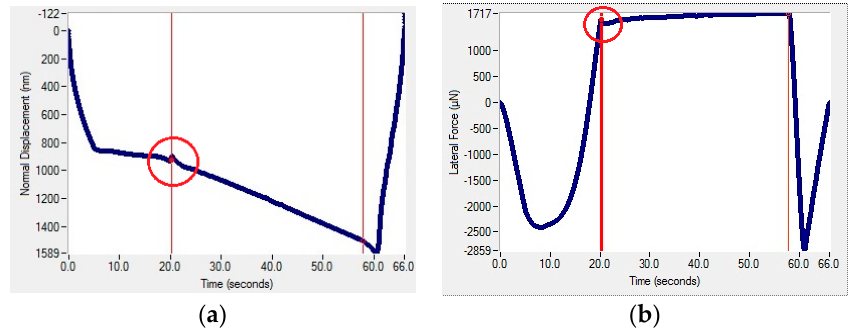
Figure 17. Representative plots of normal displacement ( a ) and lateral force ( b ) versus time from a 5000 μ N ramping force nanoscratch test on PMMA. Critical events in the data (showing point of distinct material piled up) are circled and correspond to h c and L c .